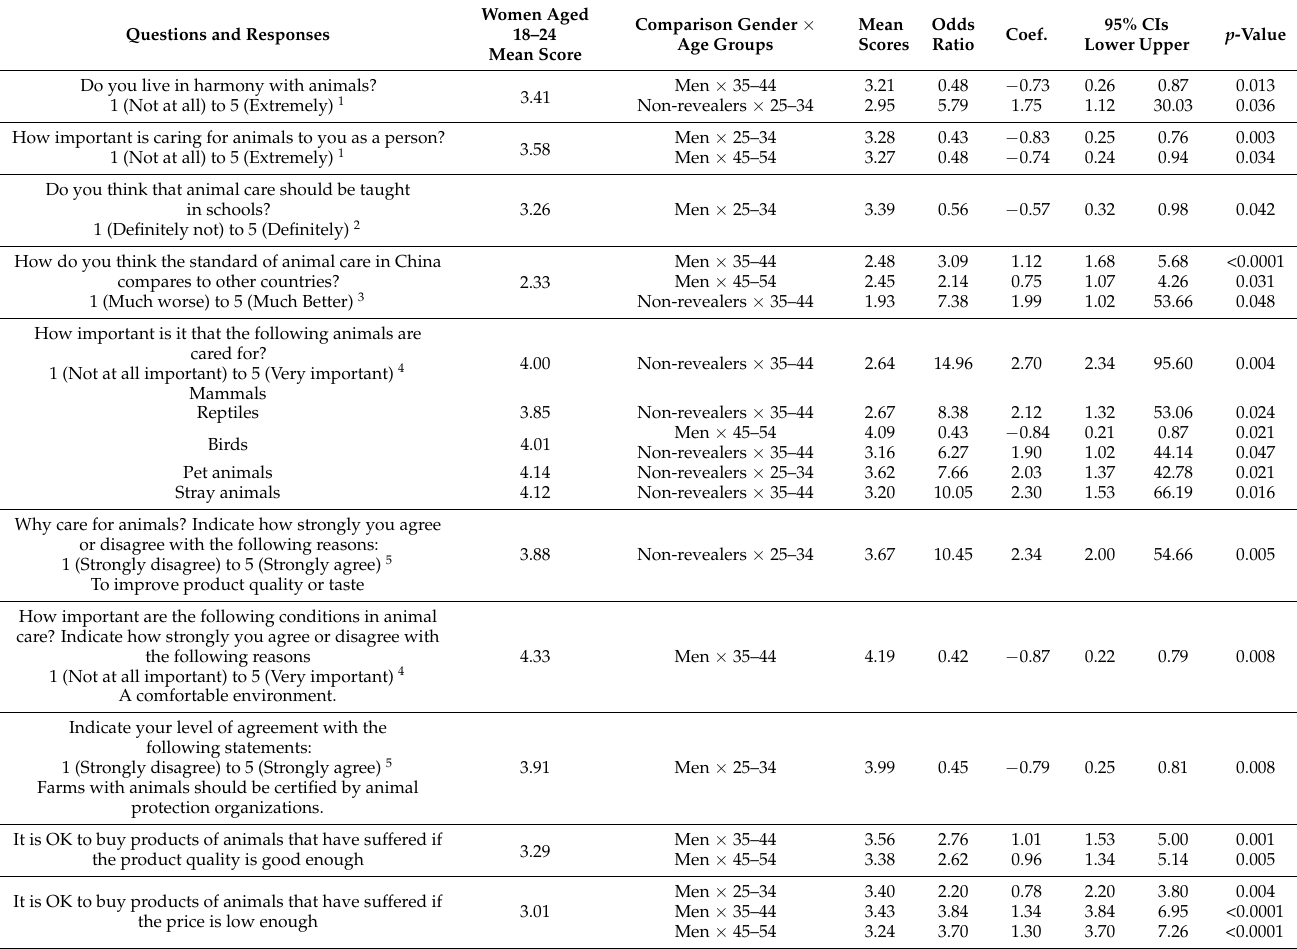
Table 1. Significant ( p < 0.05) interaction effects between gender and age on attitudes towards animal welfare in China. Mean responses on 5-point ordinal scales are provided. For gender categories, the number of respondents was 618 men; 628 women; 39 non-binary participants. For age categories,